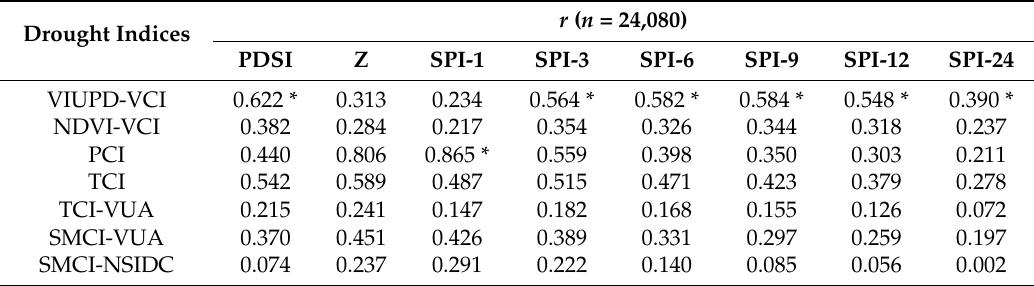
Table 3. Comparisons of the r-value between VIUPD-derived VCI and other commonly used remote sensing-based single drought indices.